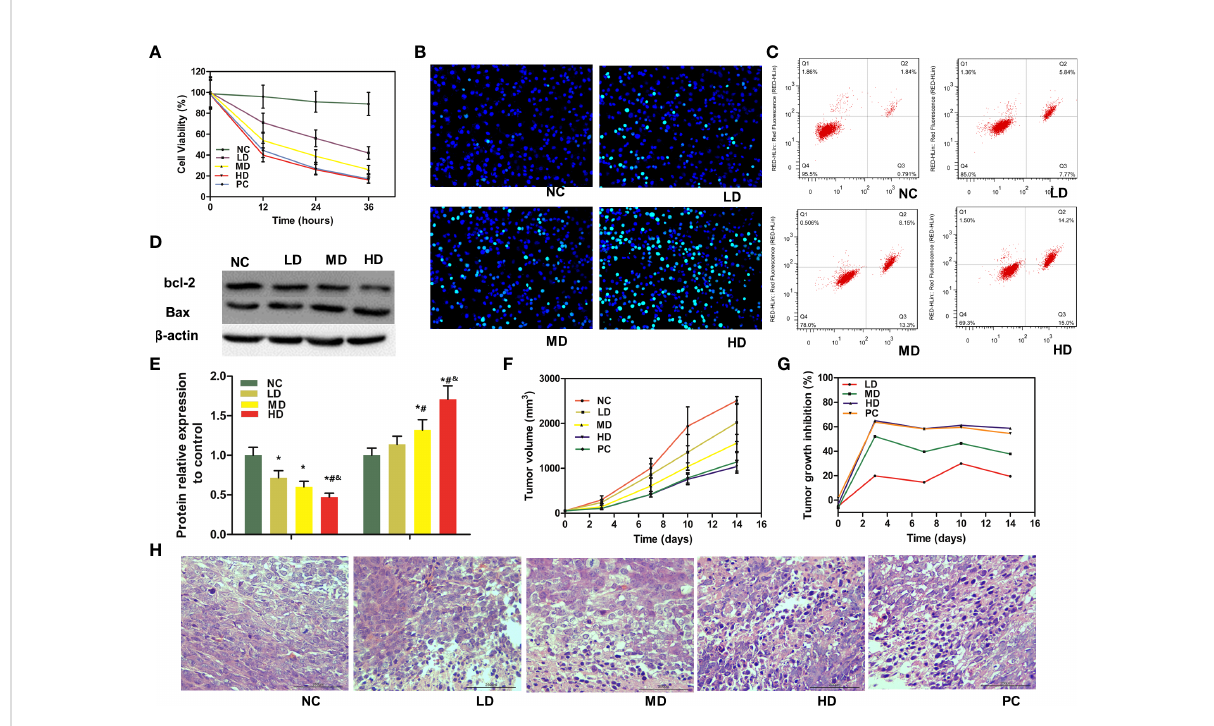
FIGURE 1 Anti-tumor ef fi cacy of WJR in vitro and in vivo . (A) Cell viability was determined by MTT assay in DLD-1 cells under WJR. (B) Hoechst 33258 staining and (C) fl ow cytometry assay were used to detect apoptosis of DLD-1 cells. (D, E) Western blot assay was implemented to analyze the expression of apoptosis-related protein Bax and bcl-2. (F) Tumor volume changes in mice treated with different groups. (G) TGI of mice in different groups. (H) H&E of tumor samples, and areas of hyperchromatic nuclei and in fi ltration of in fl ammatory cells represent necrosis. NC, control group; LD, low-dose group of WJR; MD, middle-dose group of WJR; HD, high-dose group of WJR; PC, positive group; WJR, Wenzi Jiedu Recipe. H&E, hematoxylin and eosin; TGI, tumor growth inhibition rate. *vs. NC, p < 0.05; # vs. LD, p < 0.05; & vs. MD, p <